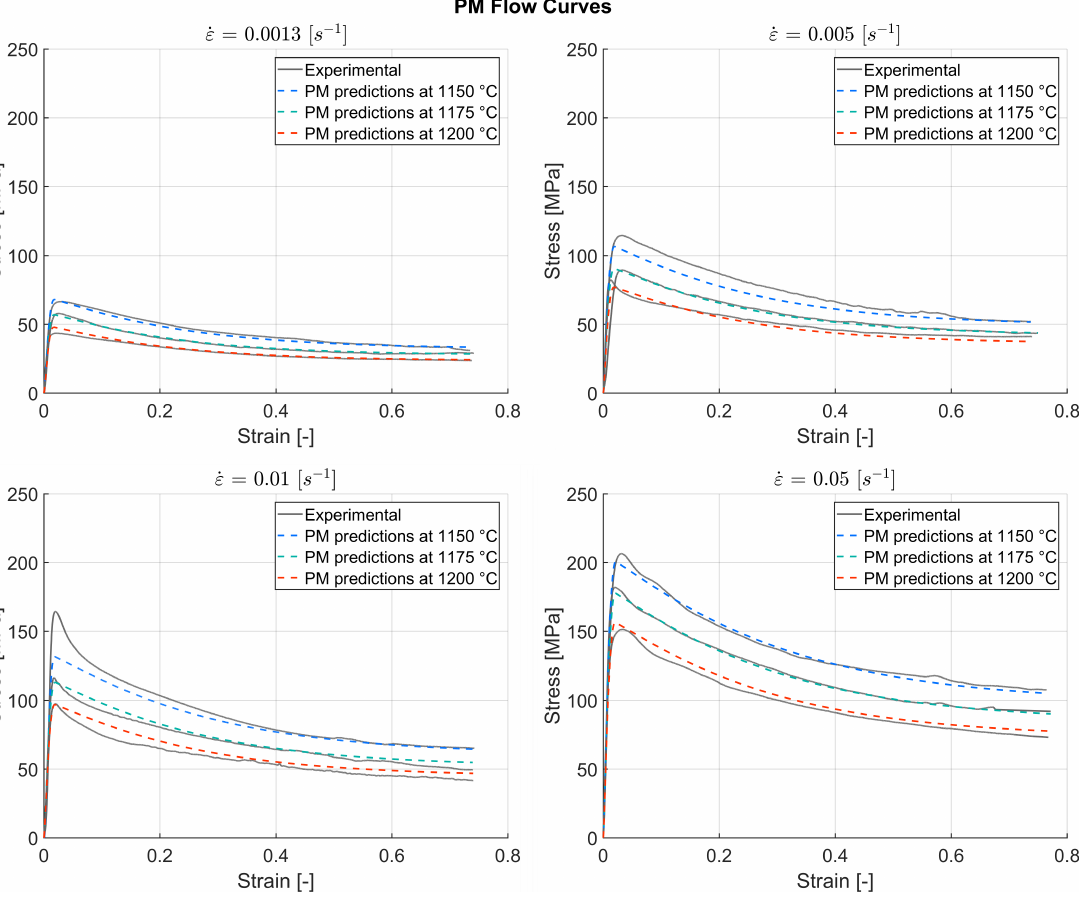
Figure 5. Experimental flow curves and the PM predictions for TNM-B1 at the temperatures 1150, 1175 and 1200 ◦ C and the strain rates 0.0013, 0.005, 0.01 and 0.05 s –1